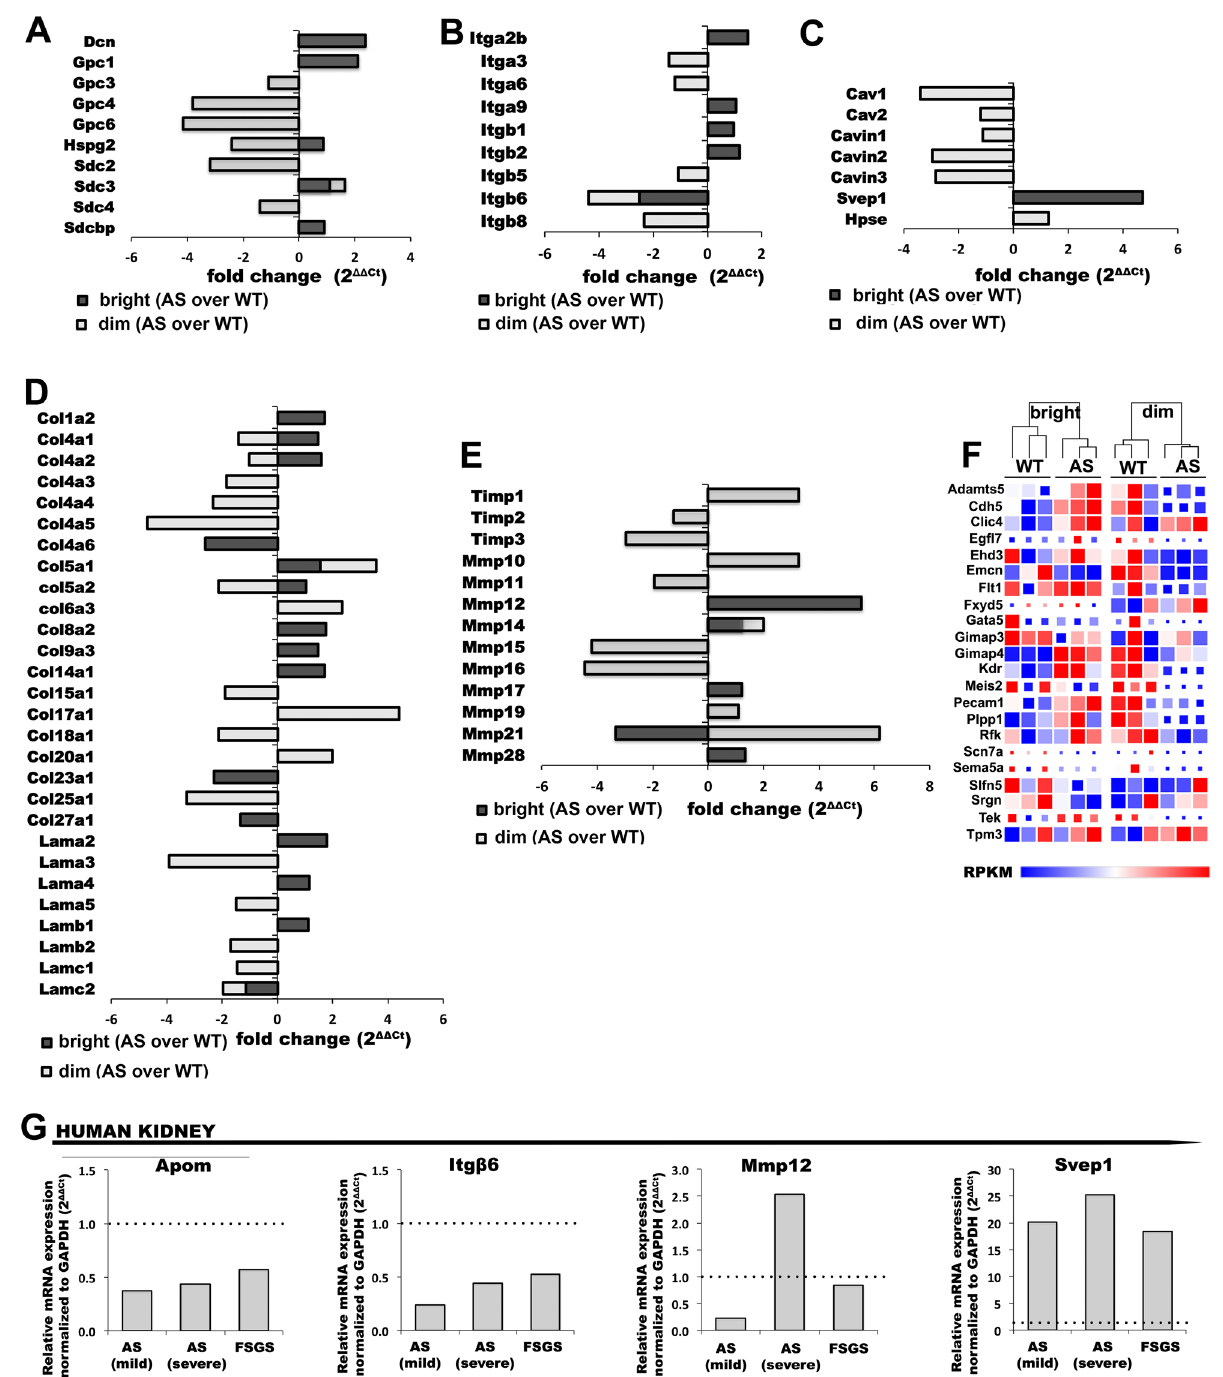
Figure 8. Comparison of extracellular matrix related differential gene expression in dim tdT and bright tdT subpopulations in AS over WT controls, and RT-qPCR analysis of Apom, Itgb6, Mmp12 and Svep1 expression in human kidney biopsy samples from Alport syndrome and FSGS patients . (A–C) Bar graphs summarizing the fold change regulation of genes expressed in bright tdT (AS over WT – black bars) and dim tdT (AS over WT – grey bars) subpopulations for glycocalyx associated proteins ( A ), integrins ( B ), extracellular matrix associated proteins ( C ). ( D, E) Bar graphs showing the fold regulation of extracellular matrix proteins ( D ), Timps and Mmps ( E ) in bright tdT (AS over WT—black bars) and dim tdT (AS over WT—grey bars) subpopulations. ( F) Heatmap diagrams with color-coded representation of the RPKM values comparing the transcriptional expression of endothelial specific genes for each subpopulation in AS to that of WT. The color scale represents relative gene expression levels across each row with red denoting upregulation and blue denoting downregulation. Color intensity indicates stronger regulation. ( G) Bar graphs showing RT-qPCR analysis and relative expression of Apom, Itgβ6, Mmp12 and Svep1 gene expression in human kidney tissue samples from AS patients with low and high level of proteinuria (AS-mild patient (n = 1): 17 years male, proteinuria: 2.5